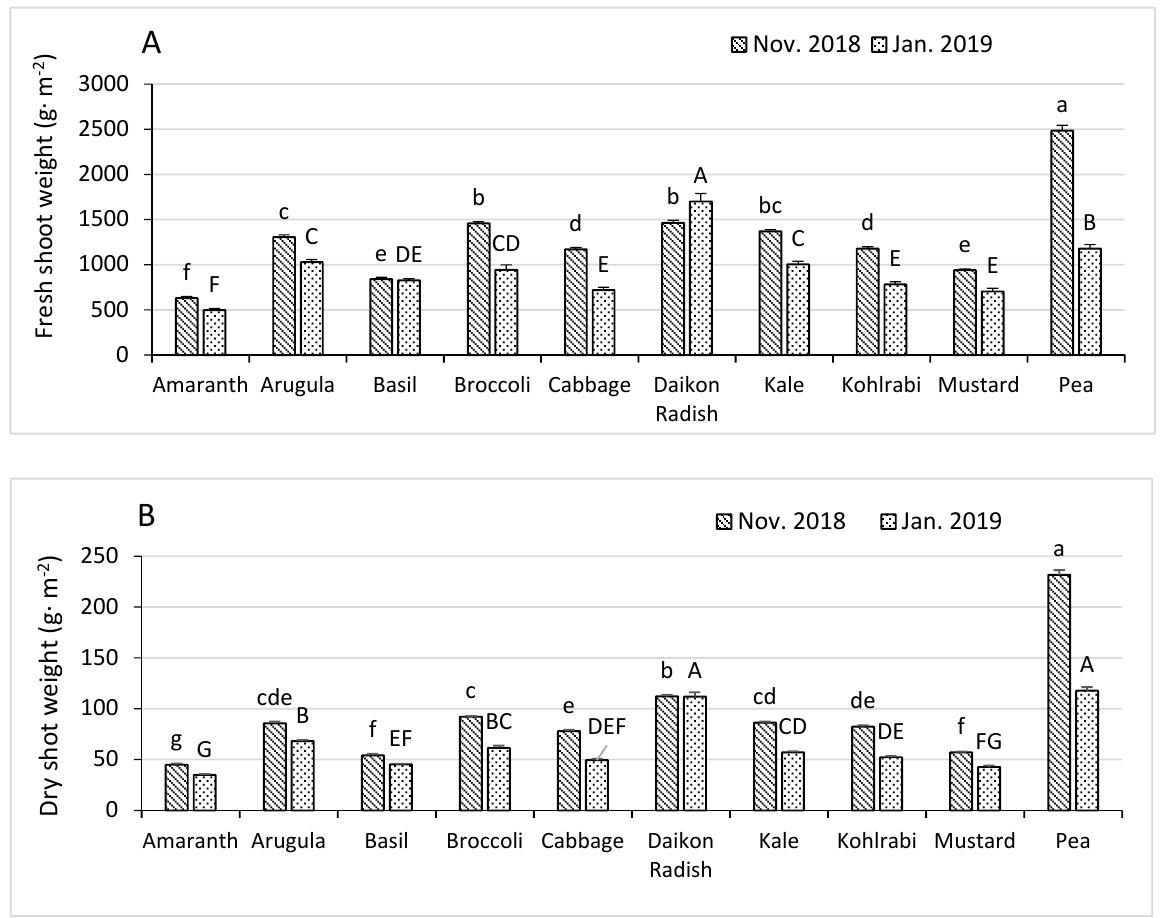
Figure 1. Fresh ( A ) and dry ( B ) shoot weights of ten species grown as microgreens. Means with standard error bars of each species were obtained by averaging data from both fertilization and pre-sowing seed treatments. Different lower case or capitalized letters suggest significant difference among species indicated by Tukey’s HSD test at α ≤ 0.05 in November 2018 or January 2019, respectively.